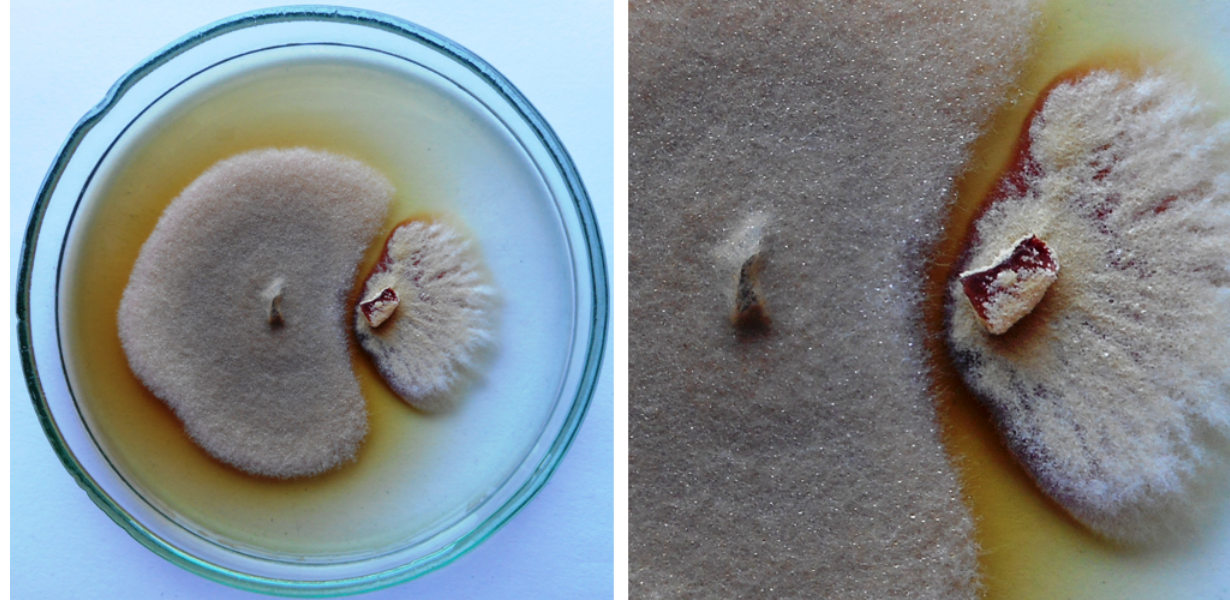
Figure 1 An example of the inhibition zone created by the secondary metabolites secreted by Epicoccum nigrum UP_EPC_31 (left side of the plate) to the PDA medium after 10 days in the paired growth with Paraphyton cookei (right side of the plate); IBE =